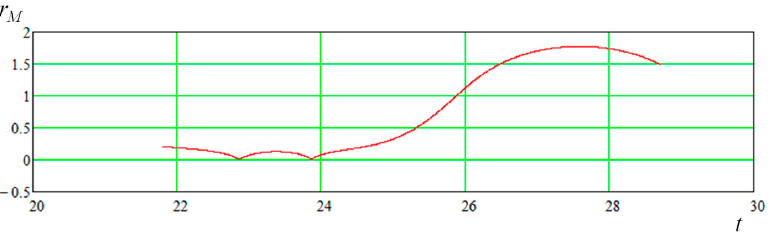
Figure 24. Relative selenocentric r M [undim.] distance between the position of the SC and the final circular orbit of a given radius.